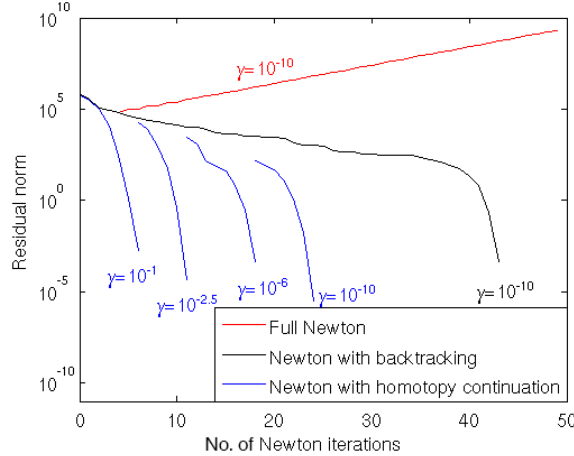
Figure 12. The robustness of Newton’s method nonlinear solves with homotopy continuation. Table 6. Meshes used in the GIS controlled weak scalability